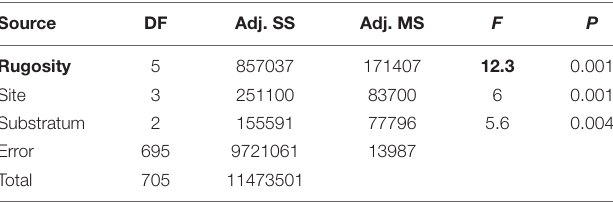
TABLE 3 | ANOVA of zoobenthic carbon storage on Ascension Island seabeds < 1000 m deep.